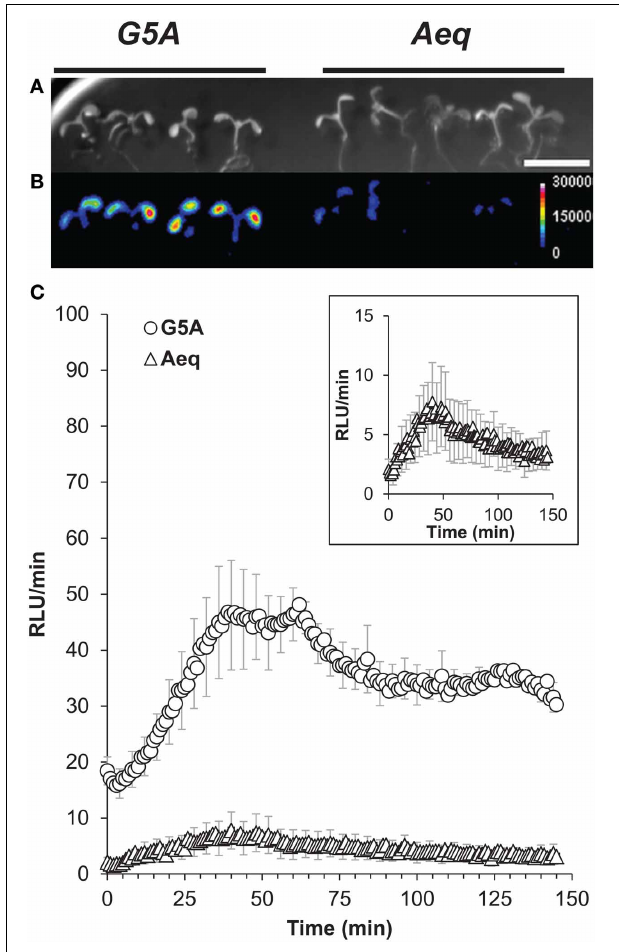
FIGURE 5 | Ca 2 + dynamics detected in response to dark onset from plants expressing G5A or aequorin. (A) Bright field view of batches of 7 day-old G5A (left) and Aeq (right) Arabidopsis reporter lines. Scale bar = 1cm. (B) Cumulative amount of light emitted from these plants after dark onset, over 150min, expressed in false colors (scale shown at right, in device-dependent arbitrary unit or “RLU,” standing for “relative light unit”). Representative results of 10 independent measurements of dark-induced Ca 2 + released. (C) 150min time course of the cumulative light emission over 60s time lapses from plants in (A , B) (data are means ± SE of 10 independent experiments with four G5A and five Aeq plants). Ca 2 + dynamics from the Aeq plants show kinetics (inset) similar to G5A plants but with approximately five times less light emission.